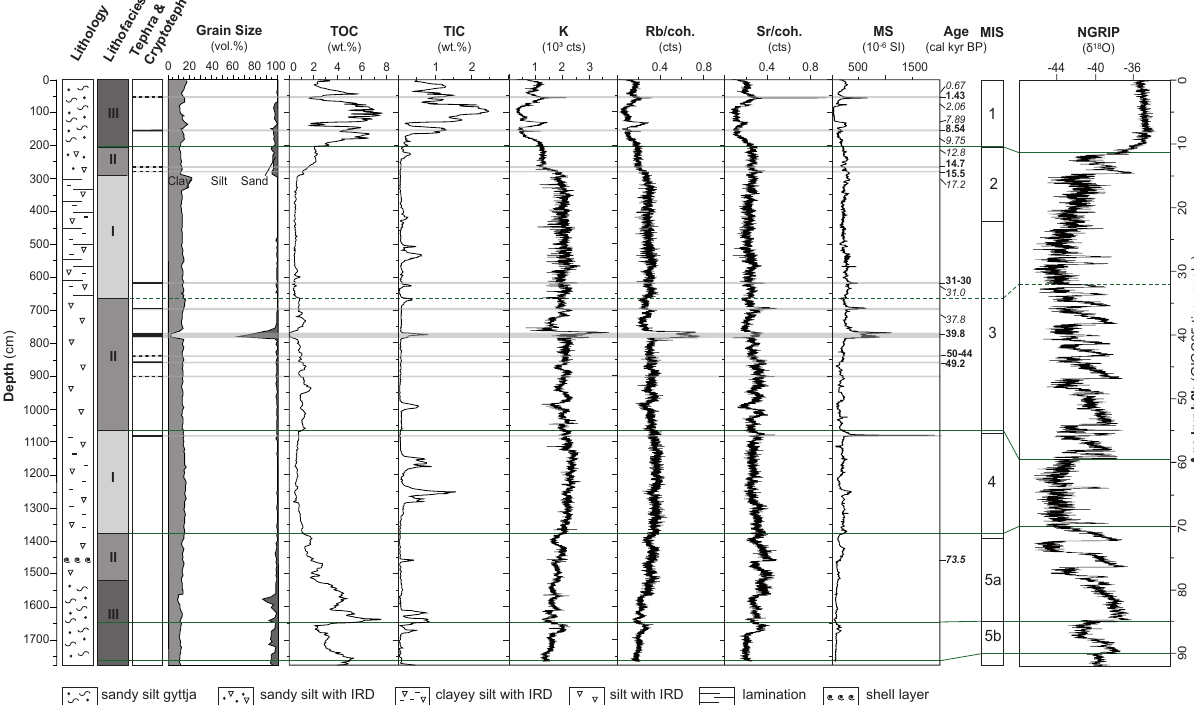
Fig. 2. Lithology, lithofacies, tephras and cryptotephras, grain size distribution, total organic carbon (TOC), total inorganic carbon (TIC), K, Rb, Sr counts from X-ray fluorescence (XRF) scanning with heavy element counts (Rb, Sr) normalised for coherent scattering (Hoff- mann, 2006), magnetic susceptibility (MS), radiocarbon ages (italics), ESR mean age (italics and bold) and tephra/cryptotephra ages (bold) from core Co1215 in comparison with the marine isotope stages (MIS) 1–5 (Bassinot et al., 1994) and the oxygen isotope dataset from NGRIP (North Greenland Ice Core Project members, 2004) based on the Greenland Ice Core Chronology 2005 (GICC05) time scale (GICC05modelext, 2010 and references therein). GICC05 ages are given in units of b2k (years before 2000AD). Green lines indicating tie points of core Co1215 with